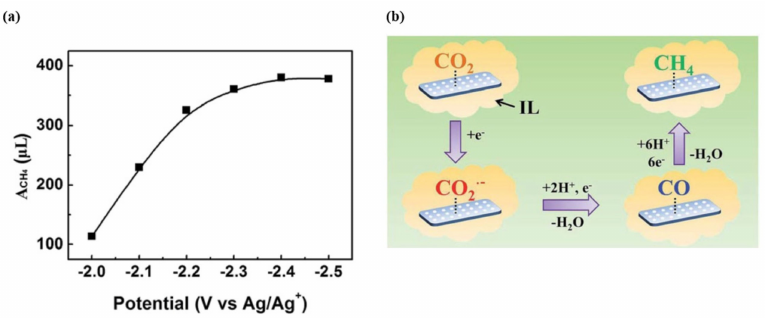
Figure 25. ( a ) The produced CH 4 ( A CH volume at standard temperature and pressure) in 2 h as a 4 (cid:48) function of potential, ( b ) the proposed reaction pathway for electroreduction of CO 2 to CH 4 on the Zn-MOF/CP cathode in ILs